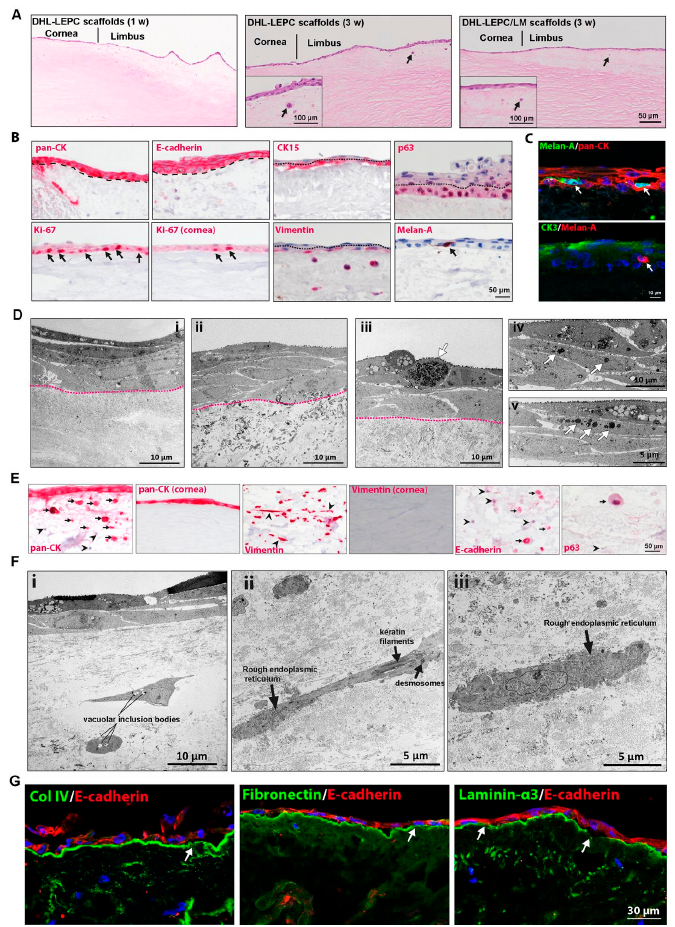
Figure 4. In vitro recellularization of the decellularized human limbus (DHL). ( A ) Light microscopic analysis of DHL–LEPC scaffolds showing cell monolayers after 1 week (1 w); after 3 weeks in culture, DHL–LEPC and DHL–LEPC/LM scaffolds showing stratified epithelium (3 w) and intrastromal invasion of epithelial-like cells (arrow) by hematoxylin and eosin staining (H&E) on the anterior surface. Insight showing the stratified epithelium and intrastromal invasion of epithelial-like cells (arrow). ( B ) Immunohistochemical staining on paraffin sections showing cytokeratin (pan-CK) expression and E (epithelial)-cadherin (magenta) in all human limbal epithelial cells (the dashed line separated the epithelium and stroma); CK15, p63, and vimentin (magenta) at basal layers of epithelial cells (dotted line separates basal and suprabasal cells); Ki-67 + cells at basal layers of epithelial cells in both limbal and corneal region (arrows); and Melan-A + melanocytes (magenta, arrow) at basal layers of the epithelium. ( C ) Double immunofluorescence staining of DHL–LEPC/LM scaffolds showing the expression of cytokeratin (pan-CK, red) in all epithelial cells; CK3 expression (green) in suprabasal cells; and Melan-A + melanocytes associated with basal cells (arrows). Nuclei stained with DAPI. ( D ) Transmission electron microscopy (TEM) micrographs of DHL–LEPC ( i ) and DHL–LEPC/LM ( ii ) scaffolds showing the multilayered epithelium (dotted line separates epithelium and stroma); darkly pigmented melanocyte in the epithelial layer of DHL–LEPC/LM scaffolds ( iii ); the presence of melanosomes in the cytoplasm of epithelial cells ( iv and v , arrows). ( E ) Immunohistochemical staining of recellularized scaffolds showing PanCK + , E-cadherin + , and p63 + cells present in the limbal stroma, whereas no invasion of LEPC occurred in the corneal region. Pan-CK − , E-cadherin − cells also present in the stroma; all cells in the stroma stained for vimentin and few with slender morphology (arrowheads). ( F ) TEM micrographs showing epithelial-like cells by their roundish shape, round nuclei, and vacuolar inclusion bodies in the limbal stroma ( i ); Fibroblast-like cells in the limbal stroma showed a mixed epithelial (keratin filaments, desmosome)–fibroblastic (spindle shape, prominent cisterns of rough endoplasmic reticulum) phenotype ( ii ); Epithelial-like cells in the limbal stroma presented signs of a fibroblastic transformation, as indicated by prominent rough endoplasmic reticulum ( iii ). ( G ) Immunofluorescence staining of recellularized scaffolds showing intact fibronectin, Col IV, and Laminin- α 3 expression with occasionally distinct gaps (arrows). Nuclei stained with DAPI. Abbreviations: LEPCs, limbal epithelial progenitor cells; LMs, limbal melanocytes; pan-CK, pan-cytokeratin; CK15, cytokeratin 15; CK3, cytokeratin 3; DAPI, 4 (cid:48)